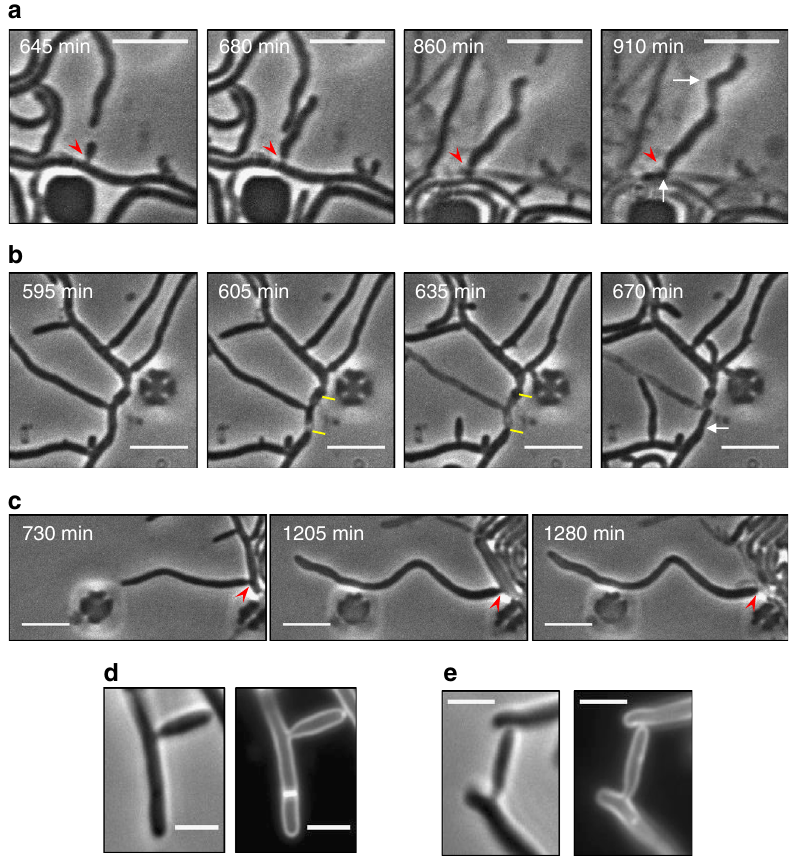
Fig. 3 Survival and sealing seem to involve branch points. Effects of lysozyme pulsing on the Δ ftsZ mutant ( a ) and wild-type ( b , c ) cells in the CellASIC ONIX micro fl uidic chamber. Cells were grown with TSB media. Red arrowheads indicate branch sites; yellow lines highlight presumable cell division sites; and white arrows show sites of cell regrowth. Scale bars = 5 µ m. d , e Bright fi eld (left panels) and FM4-64 stained (right panels) of wild-type ( d ) and Δ ftsZ mutant ( e ) cells. Scale bar = 5 µ